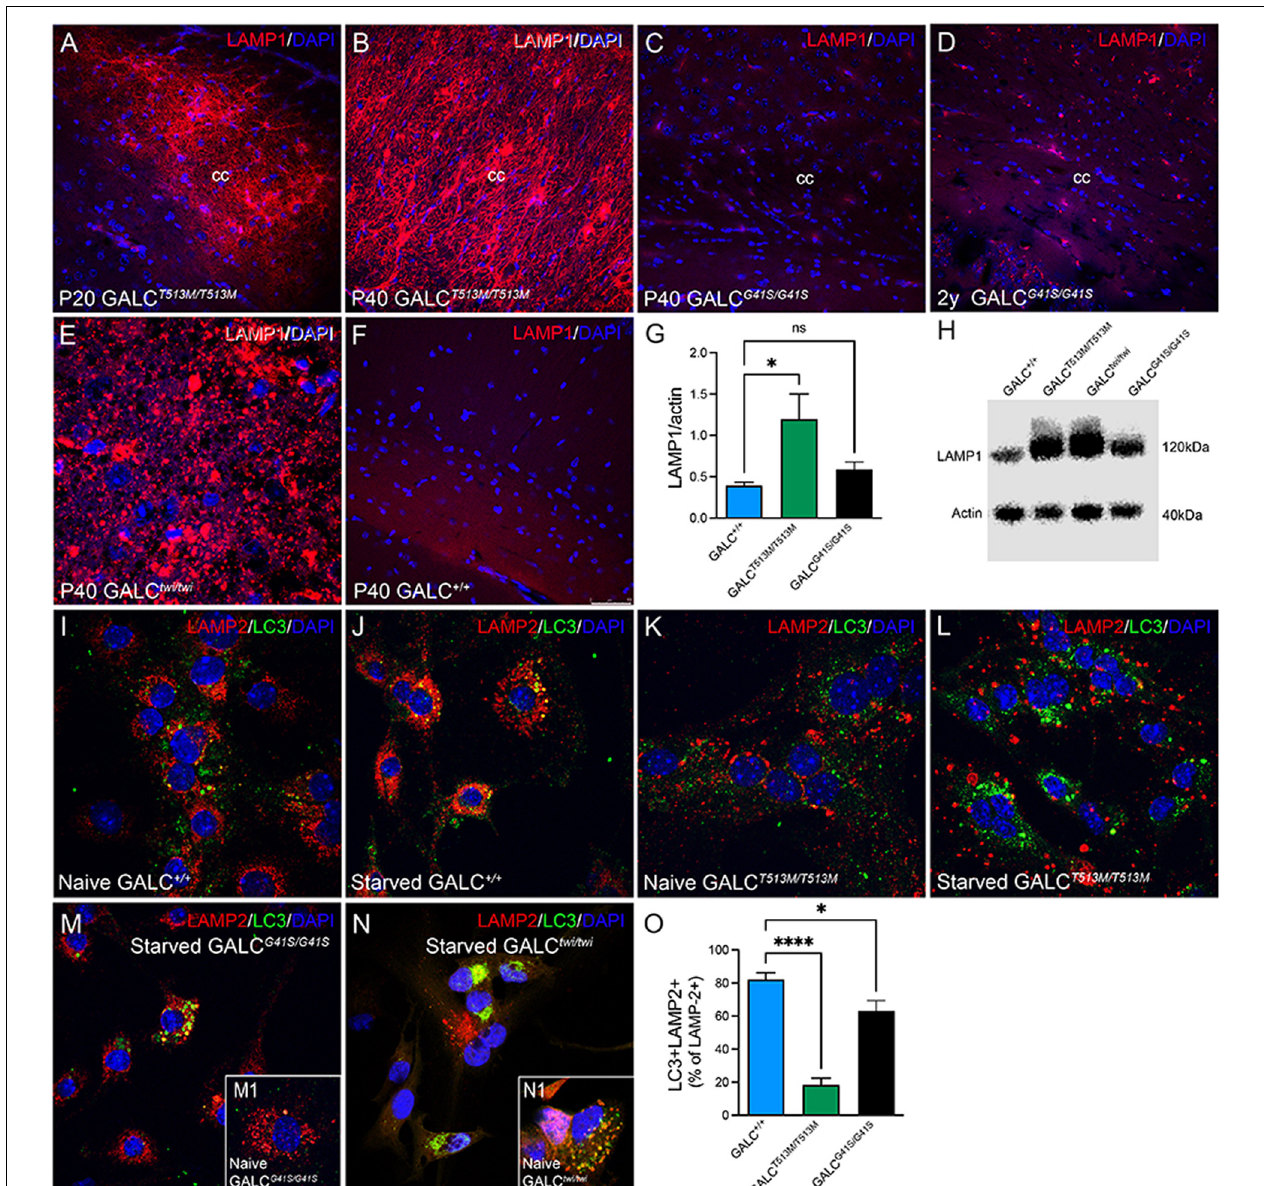
FIGURE 10 | Increased Expression of LAMP-1 in White Matter Areas of GALC T 513 M / T 513 M and GALC G 41 S / G 41 S Mice and Decreased Autophagolysosome Fusion in Cultured Neural Precursors Immunohistochemistry using anti-LAMP-1 antibodies (in red) was used to evaluated lysosomal responses in white matter areas. Confocal microscopy detected very robust increases of LAMP-1 expression in interfascicular oligodendrocytes in white matter areas like the corpus callosum in P20 (A) and P40 (B) GALC T 513 M / T 513 M mice, to levels observed in TWI mice (E) . In contrast, LAMP-1 expression in GALC G 41 S / G 41 S oligodendrocytes was increased in aged mutants (D) , but not in younger P40 (C) mice. (F) shows LAMP-1 staining in P40 GALC + / + corpus callosum. Blue stain: DAPI. Bar = 50 µ m. (G,H) Semiquantitation of LAMP-1 levels (by western blotting) in whole brain extracts. Data represent the mean + SEM of n = 4/group, analyzed by ANOVA/Tukey’s post hoc test ∗ p < 0.01; ns, not significant. (I–L) WT (I,J) and GALC T 513 M / T 513 M (K,L) cells were fed with our without (starved) 1% FBS for 4 h before double staining for LAMP-2 (red) and LC3 (green). (M,N) GALC G 41 S / G 41 S (M) and TWI (N) cells were also starved for 4 h before immunocytochemistry. Insets show naïve cells, respectively. (O) Confocal images were used for counting the total number of LAMP-2+ puncta and the number of double labeled LC3+/LAMP-2+ puncta. Data represent the mean + SEM of 15–20 cells/group, analyzed by ANOVA/Tukey’s post hoc test ∗ p < 0.05, ∗∗∗∗ p <